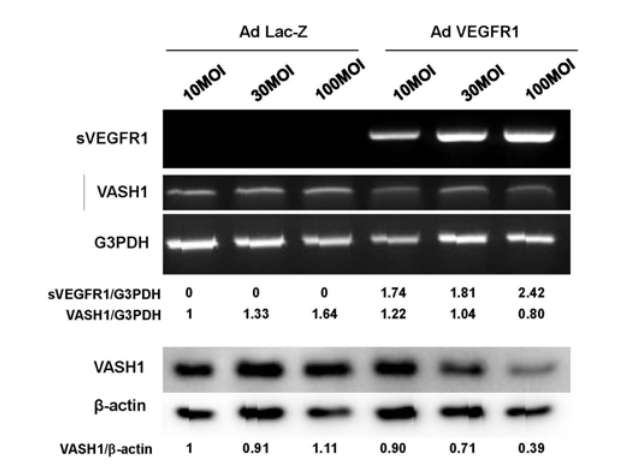
Figure 4. sVEGFR-1 inhibits VASH1 expression in